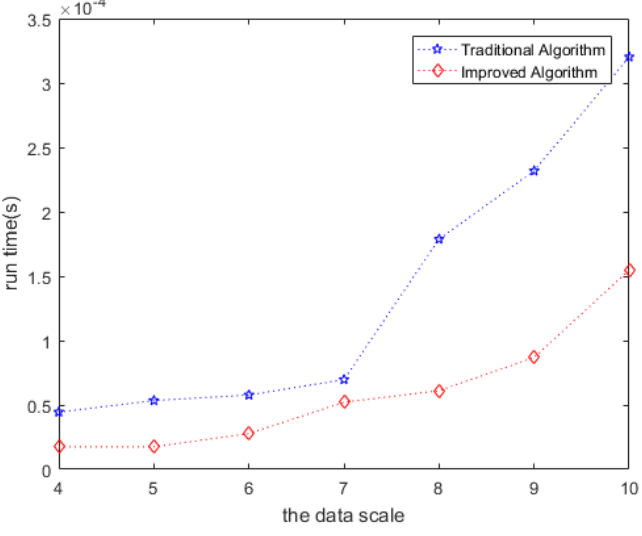
Figure 9. Comparison of the runtime between classic and improved algorithms.